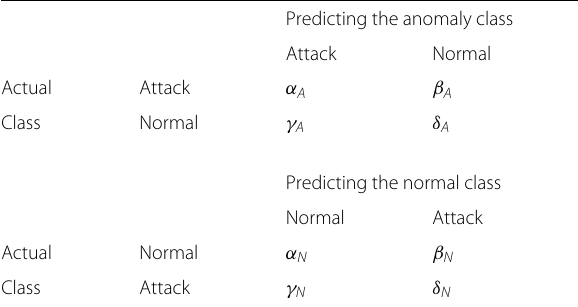
Table 2 The two-dimensional confusion matrices that define the main factors considered in IDS performance evaluation when predicting the anomaly and normal classes Predicting the anomaly